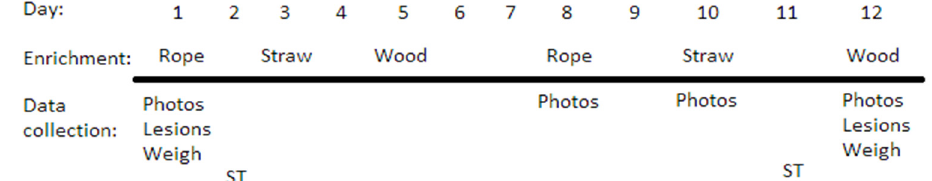
Figure 2. Photos illustrating presentation of straw ( A ), wood ( B ) and rope ( C ) enrichments to sows.